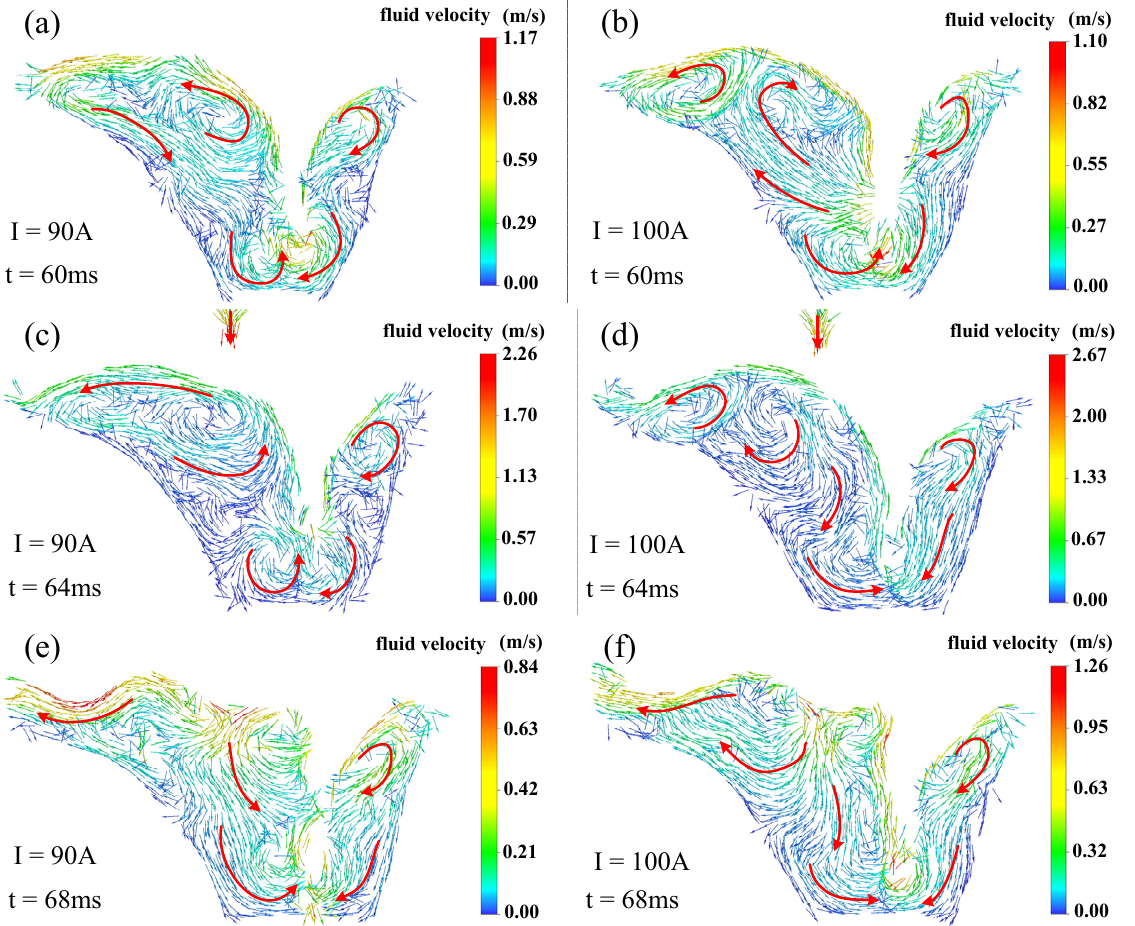
Figure 8. Simulation results of fluid flow during keyhole evolution process under different arc currents. ( a , c , e ) I = 90 A; ( b , d , f ) I = 100 A.